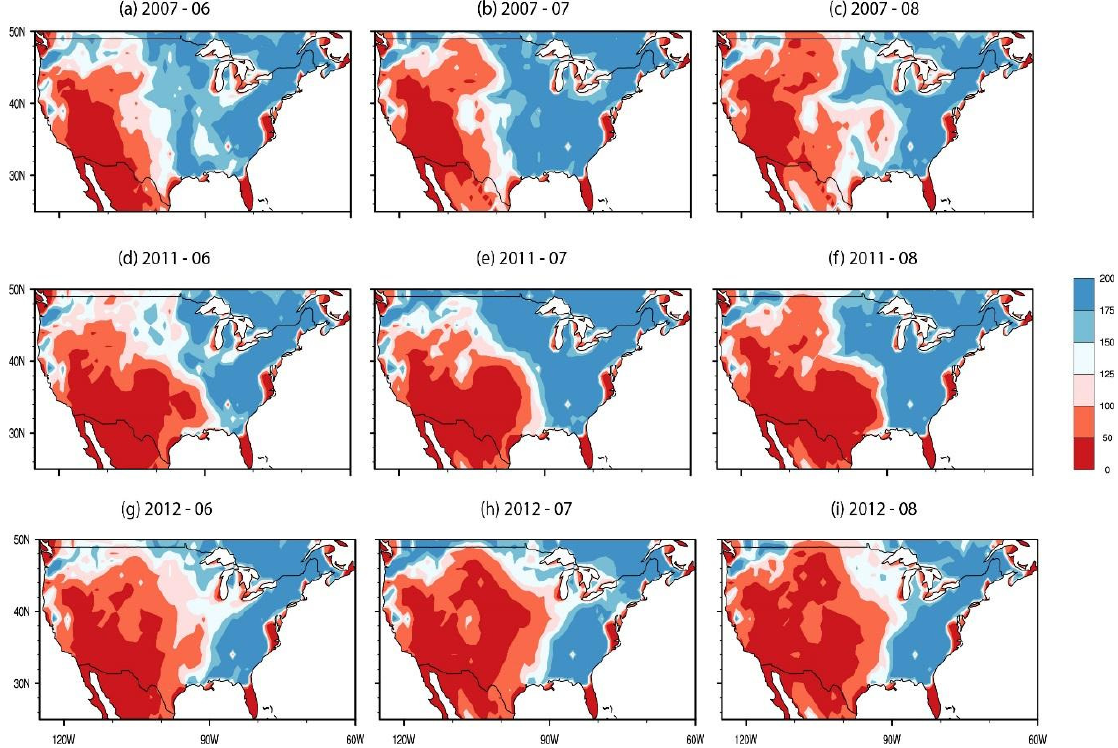
Figure 13. Gross primary production (gC/m 2 /month) from MOD17A2 data product in summer 2007 ( a – c ), summer 2011 ( d – f ), and summer 2012 ( g – i